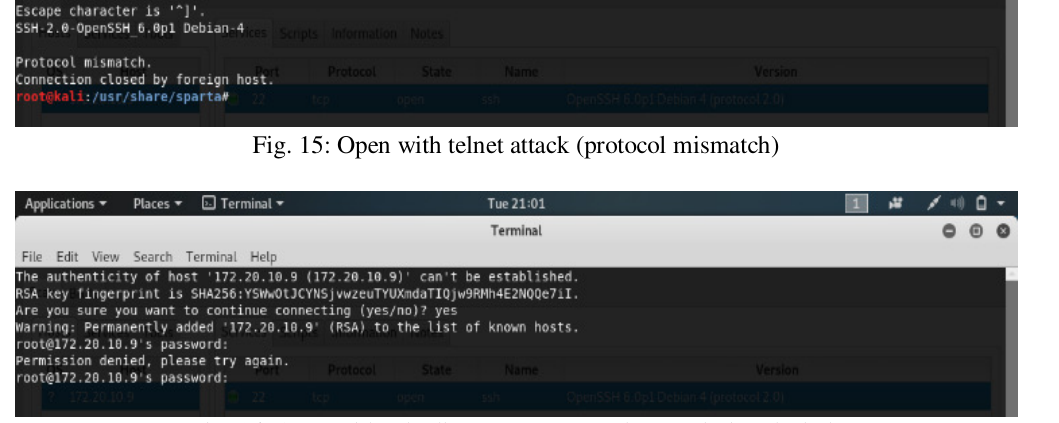
Fig. 16: Open with ssh client (as root) attack (permission denied)